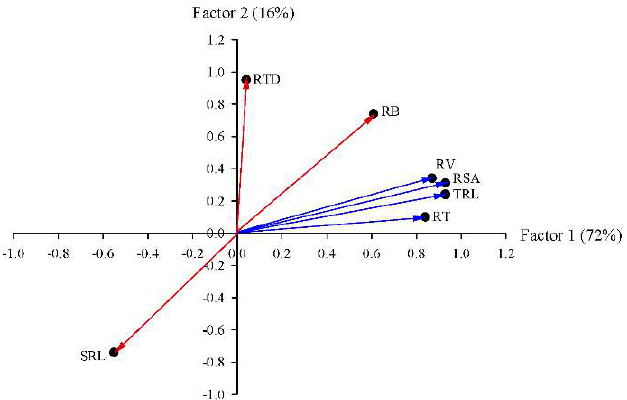
Figure 1. Factor analysis of seven root traits. Note: TRL, RSA, RV, RT, RB, SRL and RTD separately represented total root length, root surface area, root volume, root tips, root biomass, specific root length and root tissue density.